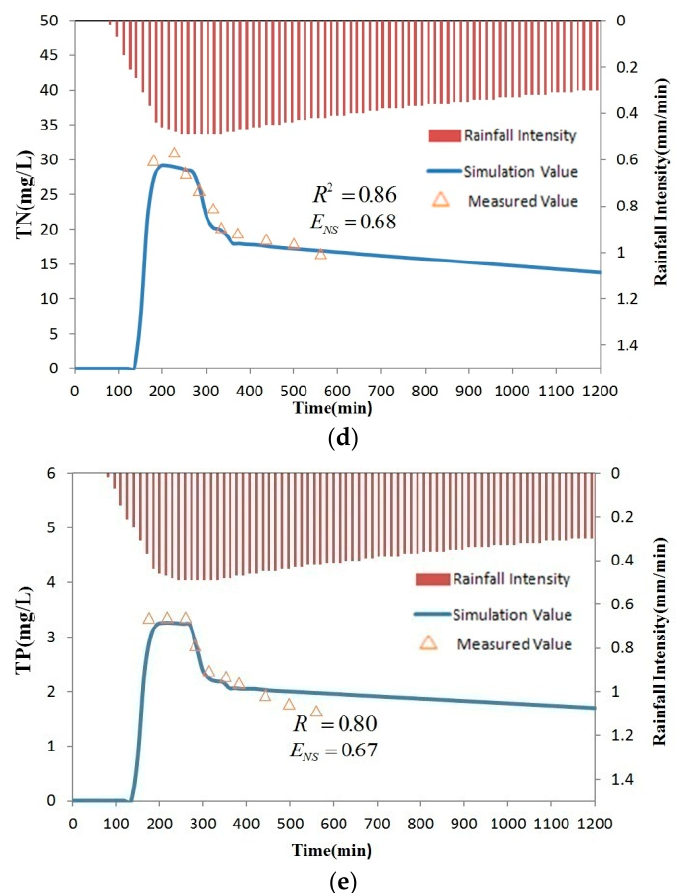
Figure 3. Parameters validation of ( a ) water quantity, pollutant validation of ( b ) SS, ( c ) COD, ( d ) TN, and ( e ) TP.